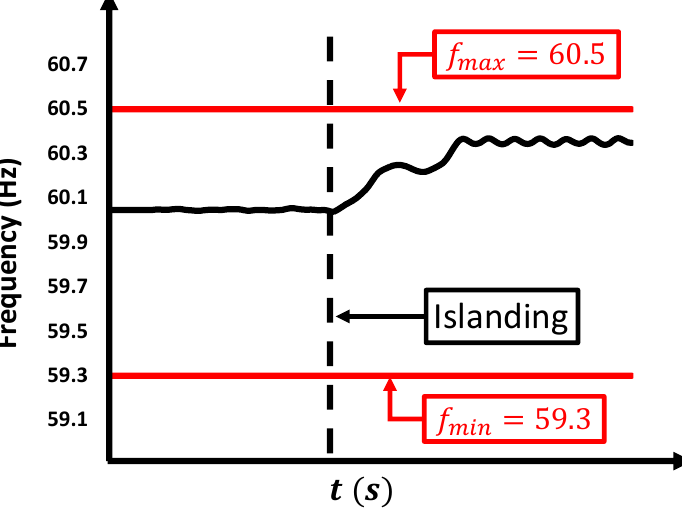
Figure 20. PCC voltage, Inverter current, Islanding. and Trip signal ( a ) under AFD implementation; ( b ) under AFD by Chen et al. (2013) [24] implementation.